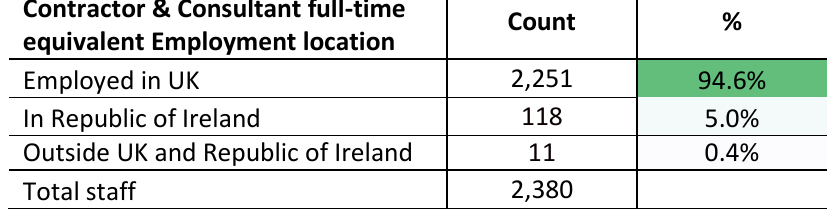
Table 2: Staff numbers by country of employment. Over 2,300 staff were working for respondents, ranging from 1 to 326 members of staff per respondent (n.b. totals differ from Table 1 as not all respondents provided specific location data).